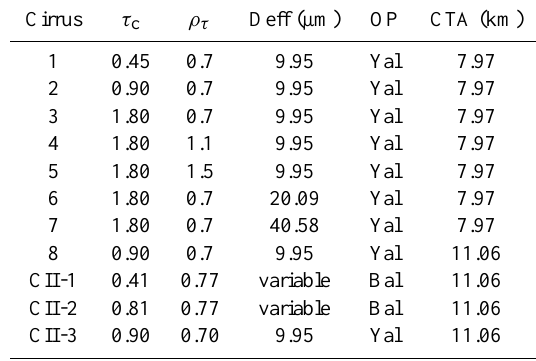
Table 1. Cirri simulated by 3DCloud. “OP" corresponds to the opti- cal properties parametrization, “CTA" corresponds to the cirrus top altitude, “Yal" represents the model of ice crystals developed by Yang et al. (2001, 2005) for aggregates ice crystals and “Bal" repre- sents the parametrization of ice crystal optical properties developed by Baran et al. (2009); Baran (2012); Baran et al. (2013).